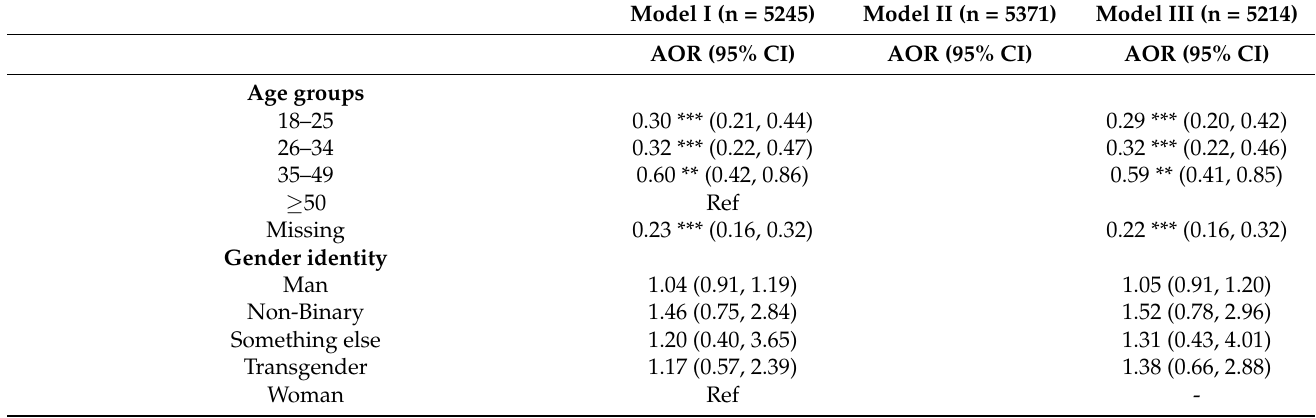
Table 2. Multivariable logistic regression analysis of the perceived likelihood of getting vaccinated and its associated sociodemographic, likelihood of contracting COVID-19, and mental health disor- der